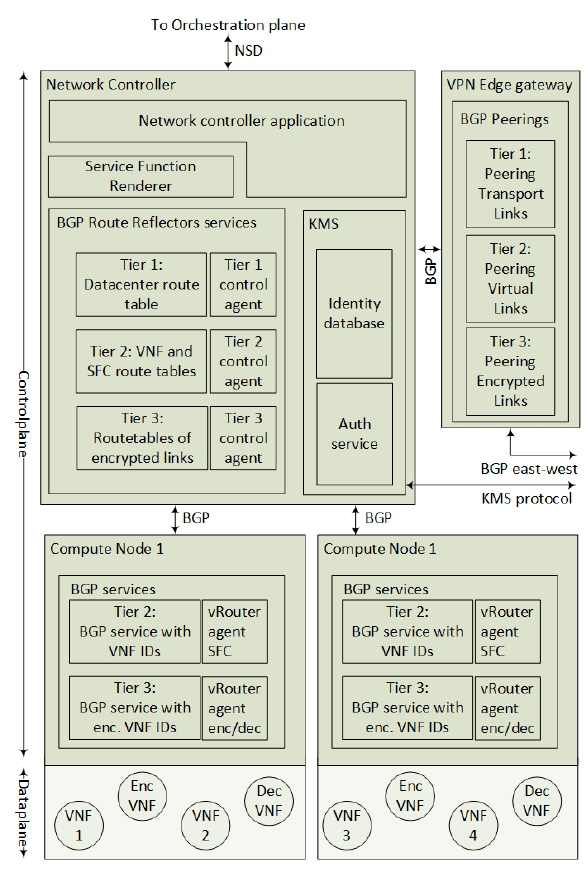
Figure 10. Services on the control